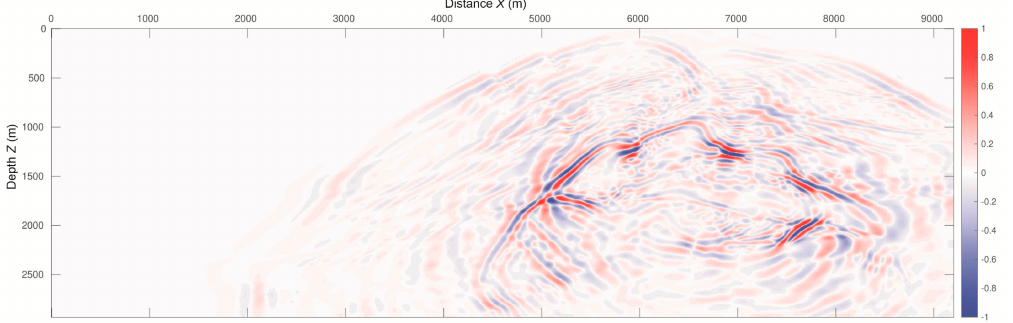
Figure 7. Snapshots computed after a 1 s simulation of the wave equation in the anisotropic two-dimensional Marmousi model. The visualization was made using the normalized and enhanced value of component v x